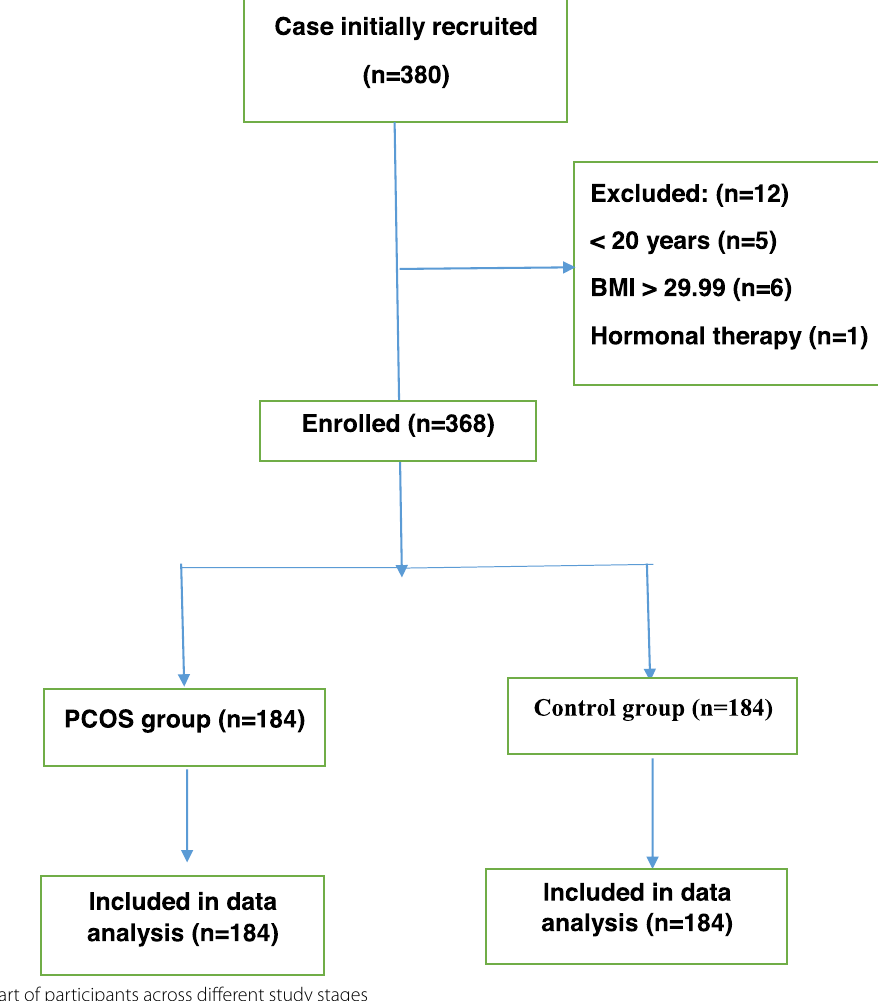
Fig. 1 Flow chart of participants across different study stages